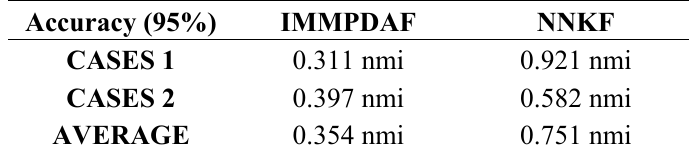
Table 2. Overall mean accuracies of the horizontal positioning for IMMPDAF and NNKF.